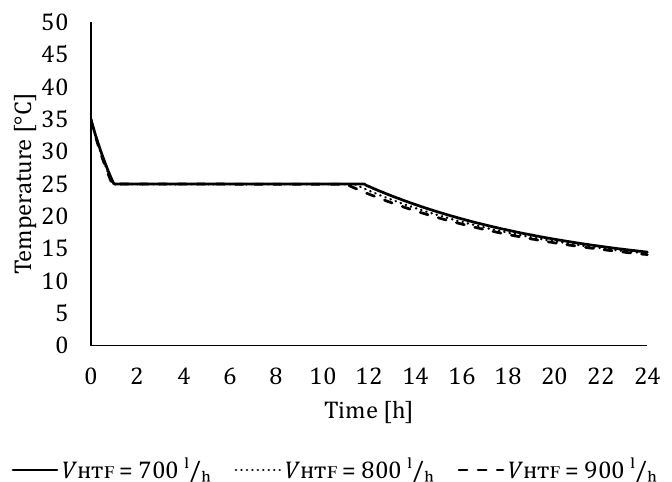
Figure 22. Comparison of transient variations of PCM temperatures during solidification obtained numerically for different HTF flow rates, HTF inlet temperature 10 °C and initial PCM temperature 35 °C.